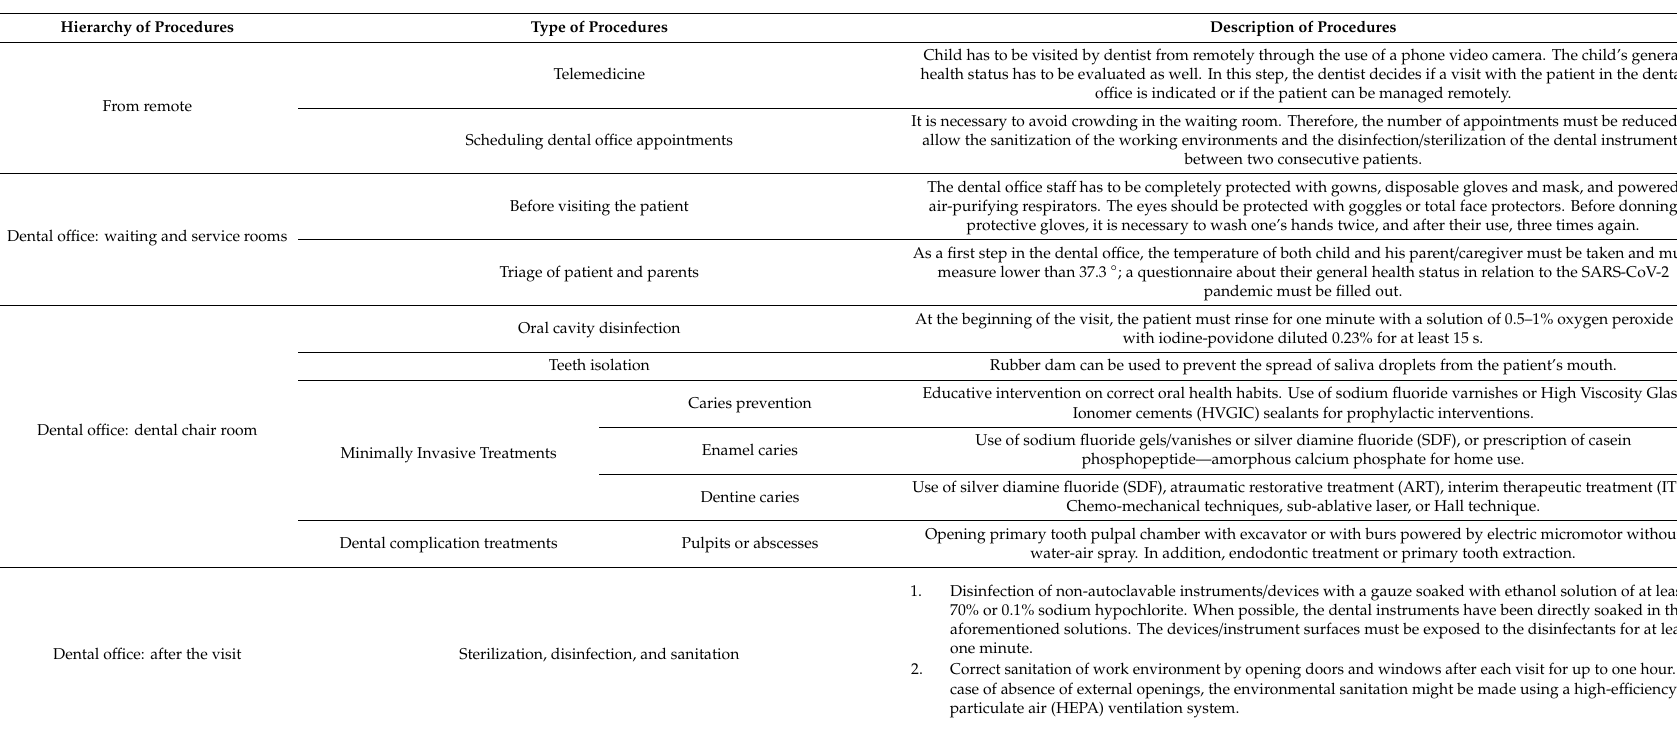
Table 2. The table shows the point to point workflow form management of a patient with ECC in the SARS-CoV-2 pandemic. Hierarchy of